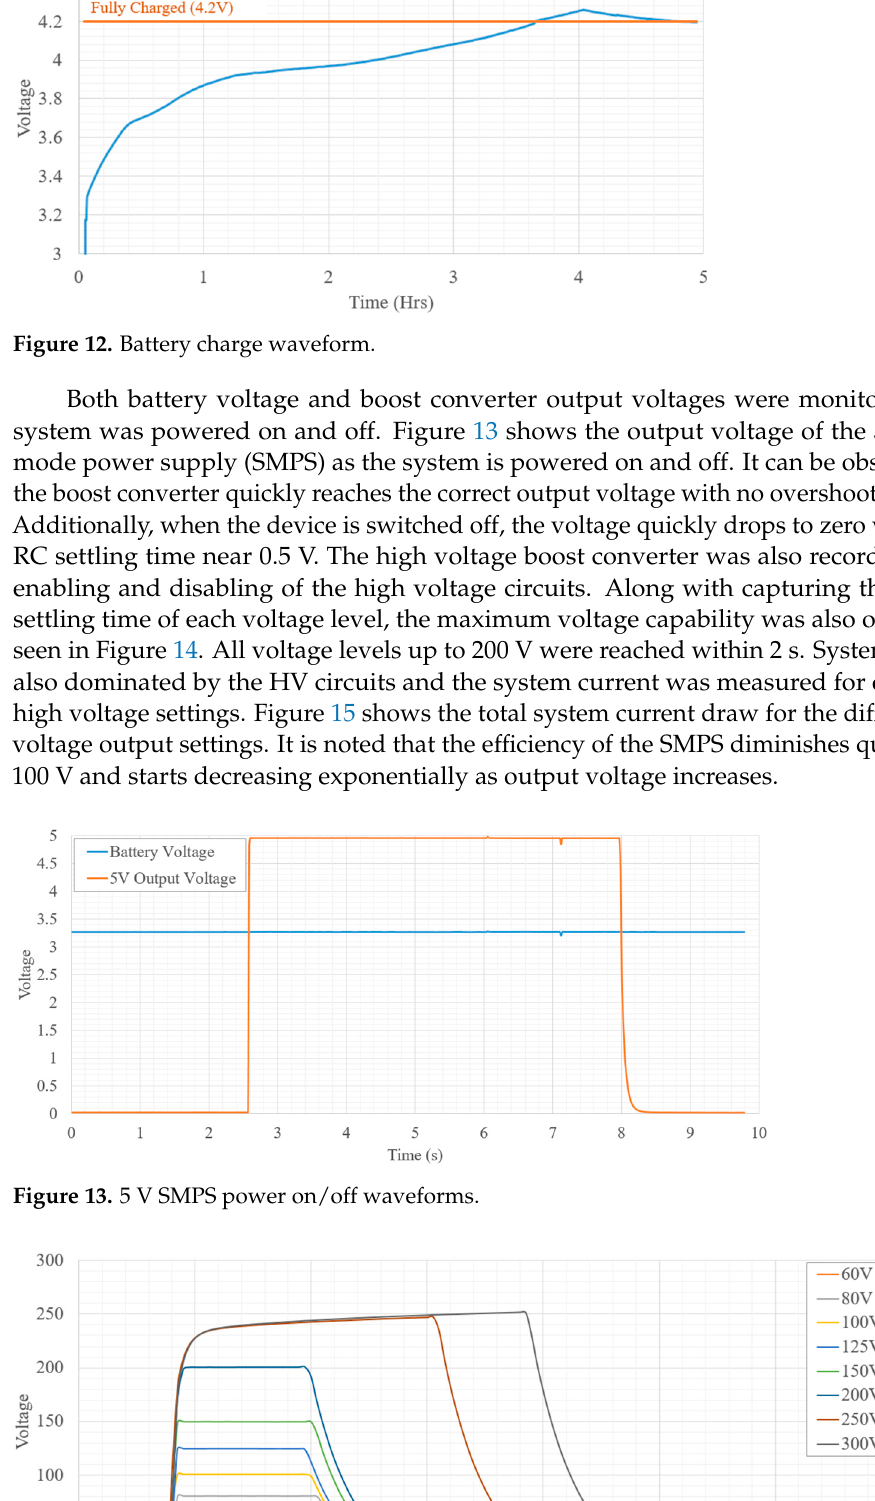
0510152025 Figure 15. System current consumption for different activation voltage levels. 3.2. Adaptive Activation Control from Droplet Position Feedback The capability of the feedback circuit was demonstrated by recording the values of V sense while moving a droplet in a loop over a select group of pads. Figure 16 shows the recorded values of V sense over time by the analog-to-digital converter of the microcontrol- ler as droplet was cycled around the loop manually four times. The location of each pad shown in Figure 16 is color coded green in the corresponding diagram below each cap- tured V sense waveform. Most of the pads show ideal results where the magnitude of V sense asymptotes to the desired value as the droplet moves over the active pad. Additionally, on each pass of the loop, the same threshold voltage is reached. Pad 24 highlights possible damage to the pad resulting in a slightly higher voltage seen on V sense . Since most of the voltage drop from the active pad is over the droplet and dielectric layer, any damage caused by breakdown lowers the resistance, which raises the voltage over R tune . Some pads, such as 41, show a slower rise to its max voltage during the early cycles, and droplet movement becomes faster with every additional cycle. This implies that the droplet is be- coming easier to move with each use. Longer movement time is a result of higher resistive forces on that pad possibly due to surface imperfections. Pads 25 and 37 have slightly higher max voltages which could also be caused by manufacturing variations. Overall, these results provide insight into many variations the system must face. This information was then used to create an adaptive algorithm in firmware to help reliably move droplets.